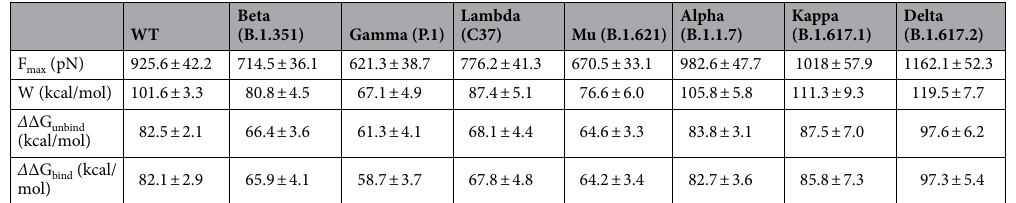
Table 4. Rupture force ( F max ), pulling work ( W ), and non-equilibrium binding ( ∆G bind ) and unbinding ( ∆G unbind ) free energies obtained from five independent SMD trajectories with v = 0.5 nm/ns for H11-H4– RBD. Results are shown for WT and variants Alpha, Beta, Gamma, Kappa, Delta, Lambda and Mu. The errors represent standard deviations.